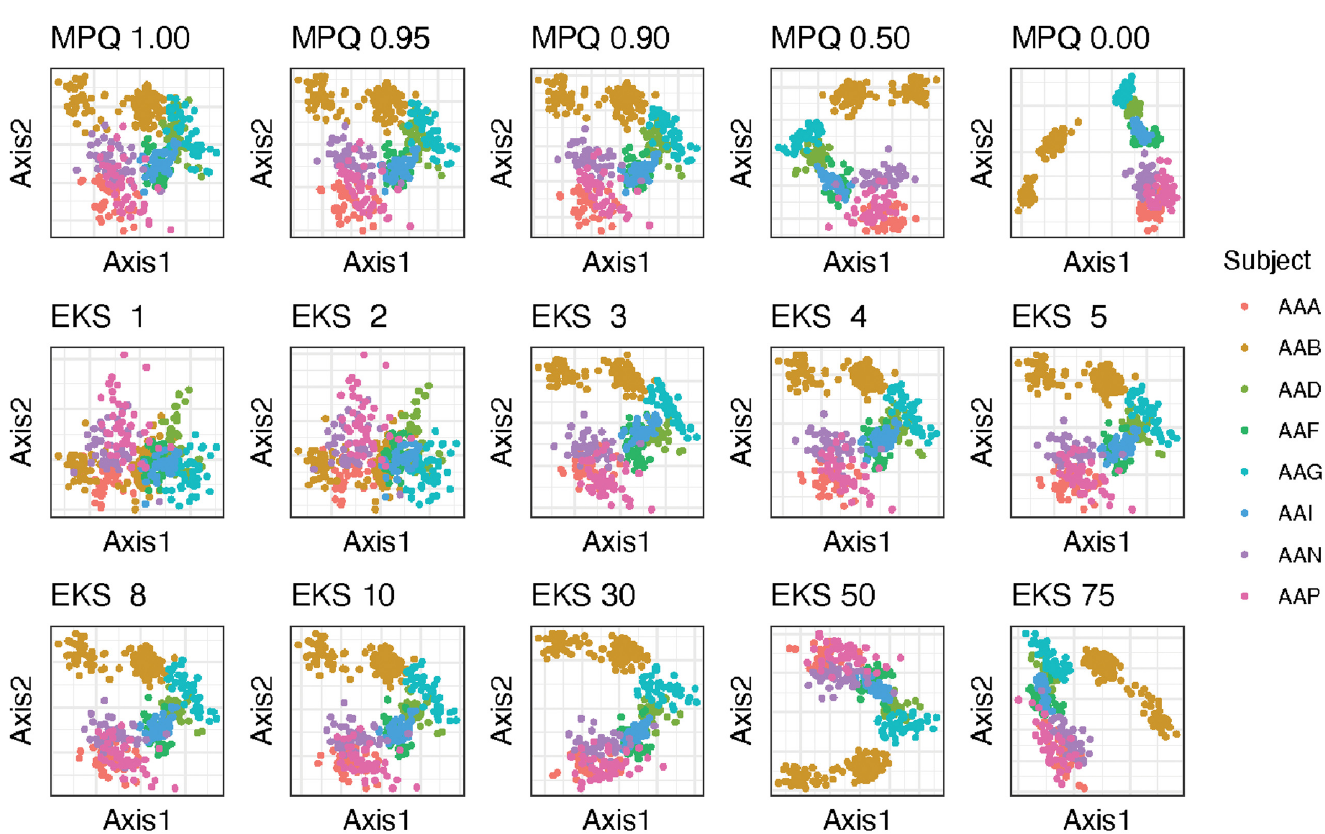
Fig 10. EKS distances with small values of k give representations of the colon cleanout samples that are similar to the MPQ distances with large values of r . Large values of k give representations of the samples that are similar to the MPQ distances with smaller values of r . For each type of distance, a distance matrix describing the relationships among the samples in the colon cleanout dataset was computed, CMDS was performed on the distance matrix, and the samples were plotted on the top two CMDS axes. Within each panel, each point corresponds to one sample in the colon cleanout dataset, and the color of the point represents the individual from whom the sample was